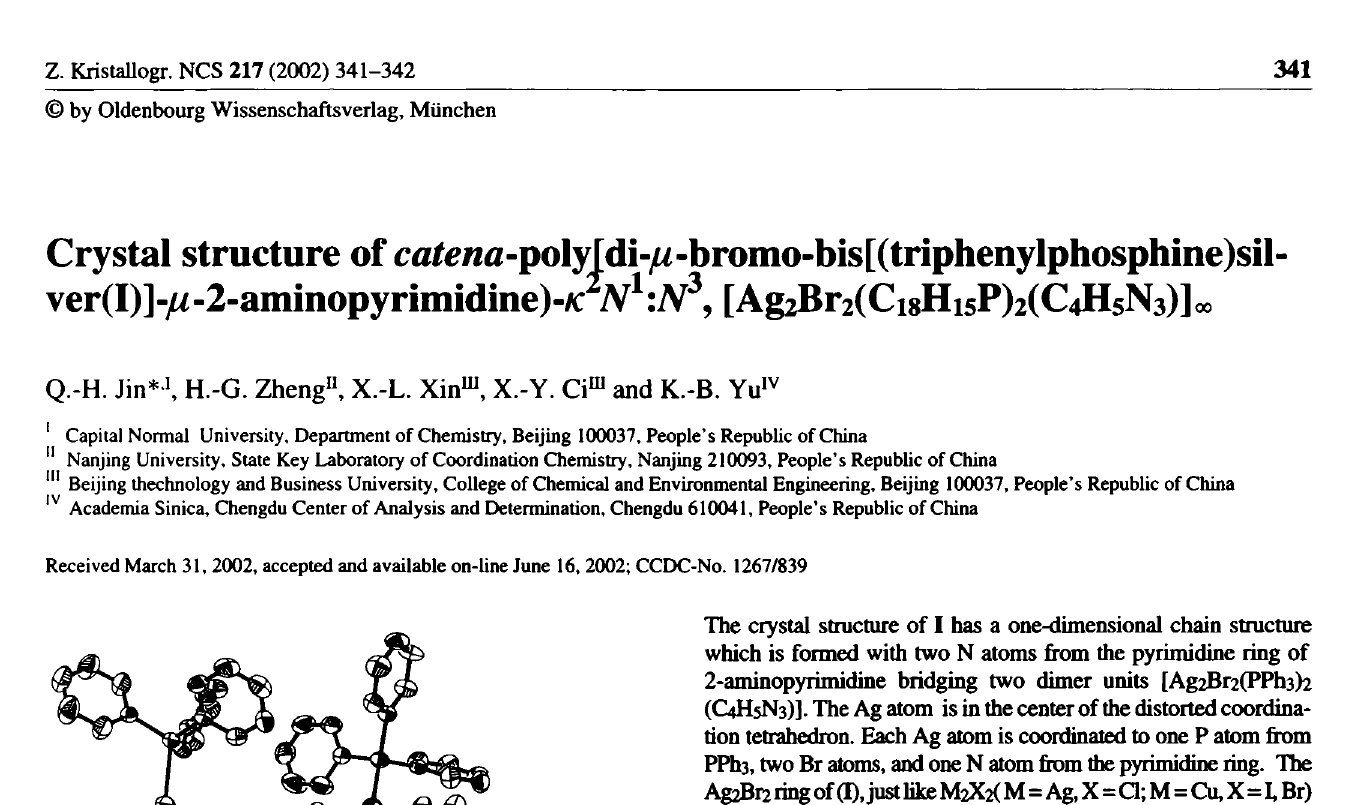
Table 1. Data collection and handling.